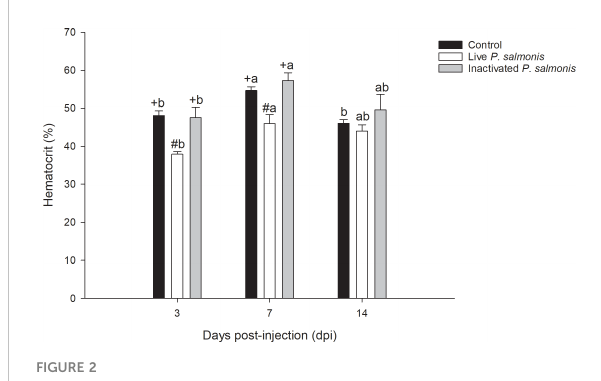
FIGURE 2 The hematocrit percentage in the blood of S. salar . The samples were taken at 3, 7, and 14 days after injection (dpi). Black bar: control condition, white bar ( fi sh stimulated with live P. salmonis ), and gray bar ( fi sh stimulated with inactivated P. salmonis ). Symbols (+, #) over the bars indicate statistical differences between the different treatments at the same time points. Different letters (A, B) indicate statistical differences in the same treatment at different times. Two-way ANOVA, p < 0.05;